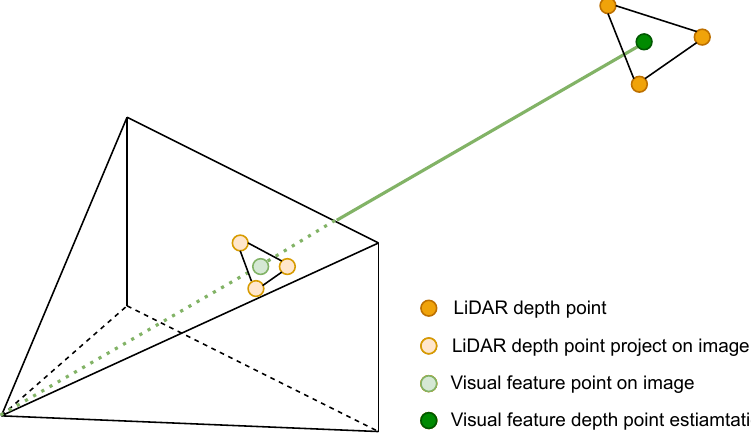
Figure 2. Visual feature depth registratoin with LiDAR